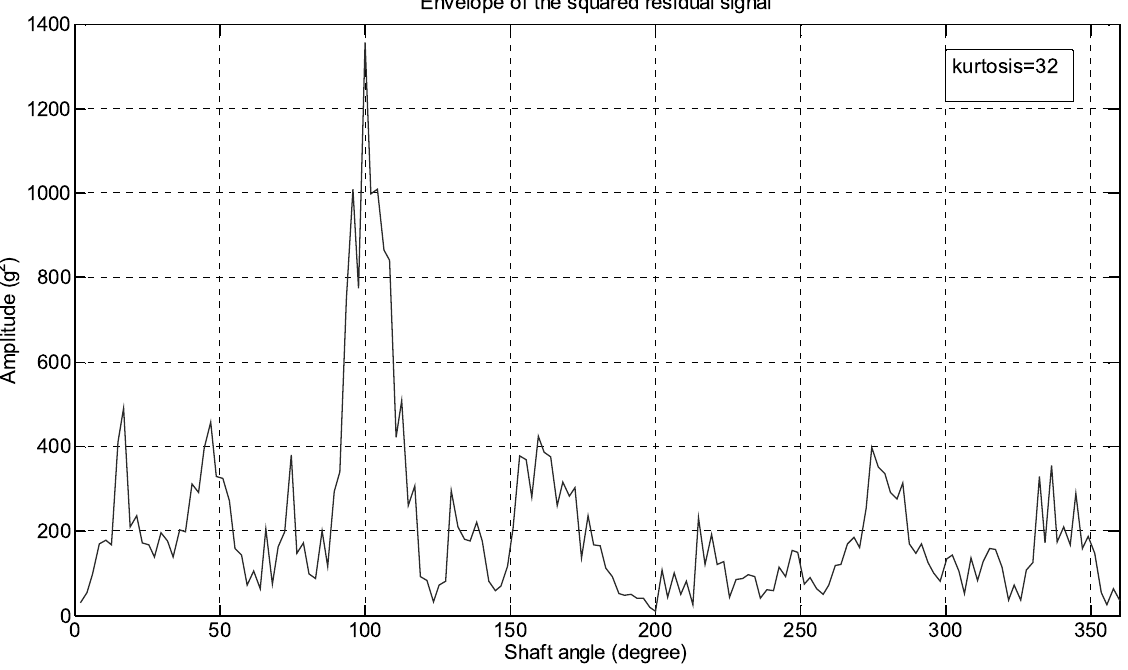
Fig. 17. Envelope of the squared residual signal in the time domain for 5% fault in the 7th